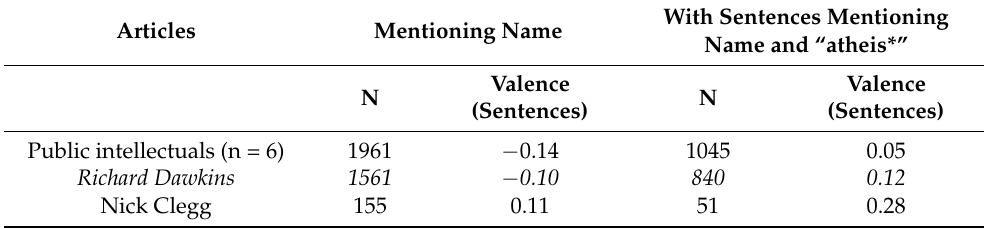
Table 6. Sentiment analysis: the average tone of texts containing the names of prominent atheists.